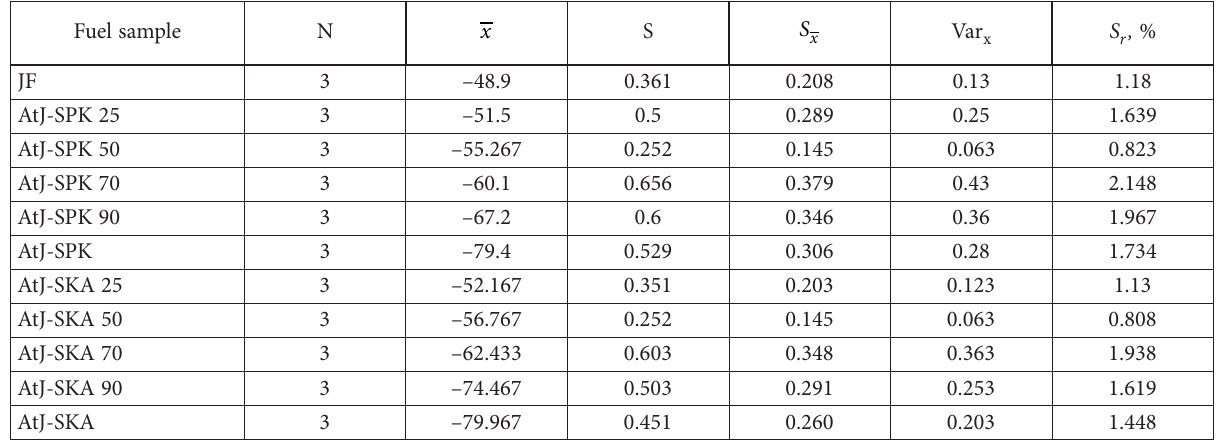
Table A3. Statistical error analysis of the freezing point measurements (source: author development)